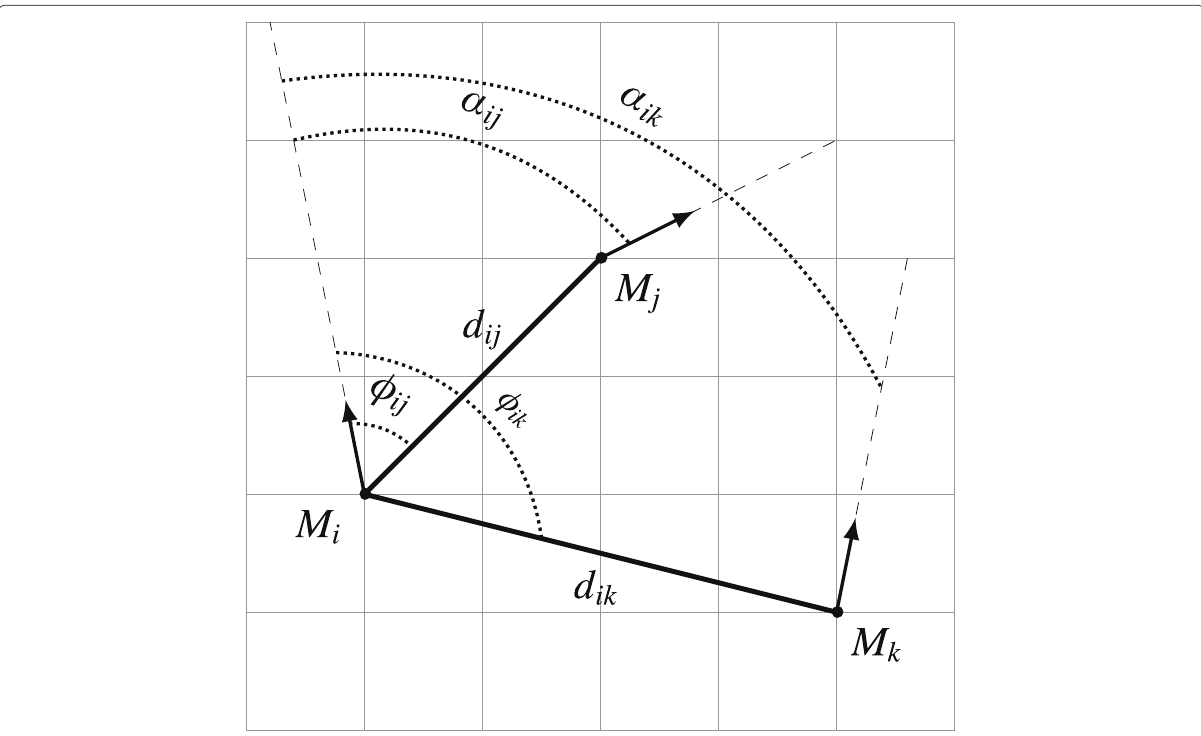
Fig. 1 Properties of the local structure involved in